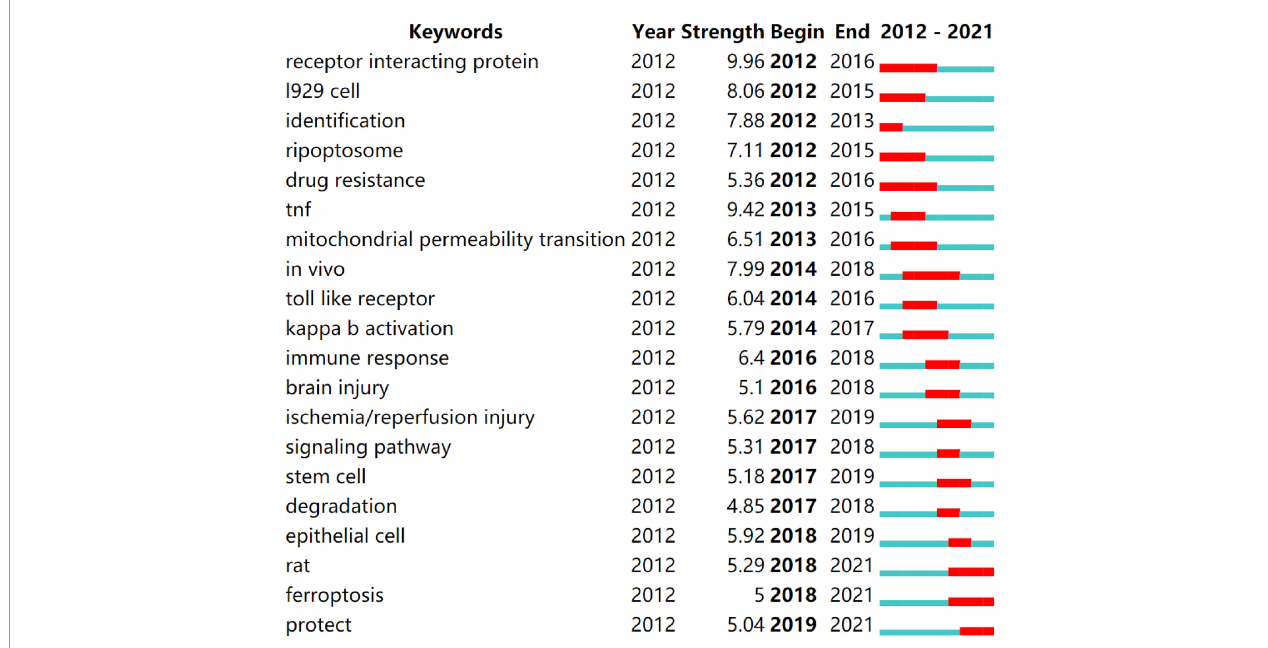
FIGURE 9 | Top 20 keywords with the strongest citation bursts (sorted by the starting year). The red bars mean citation